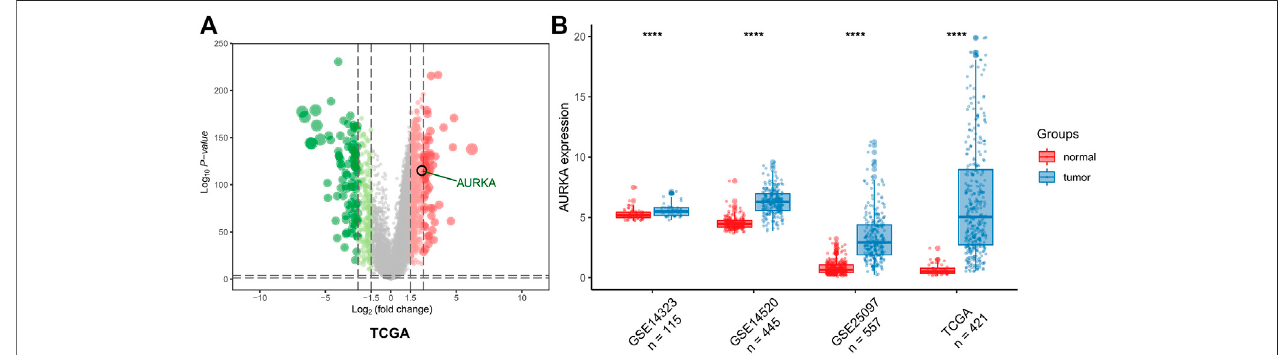
FIGURE 2 | AURKA expression. (A) Volcano plot of all DEGs. AURKA gene was identi fi ed. (B) Histogram of GSE14323, GSE14520 and GSE25097.